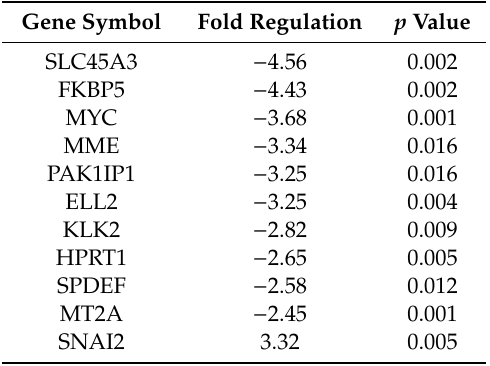
Table showing downregulation of AR downstream genes with CYP3A5 siRNA treatment in MDAPCa2b cells. The fold change is in comparison with NT (non-target) pool siRNA treatment. The fold changes of all tested genes present in the array is listed in supplementary Table